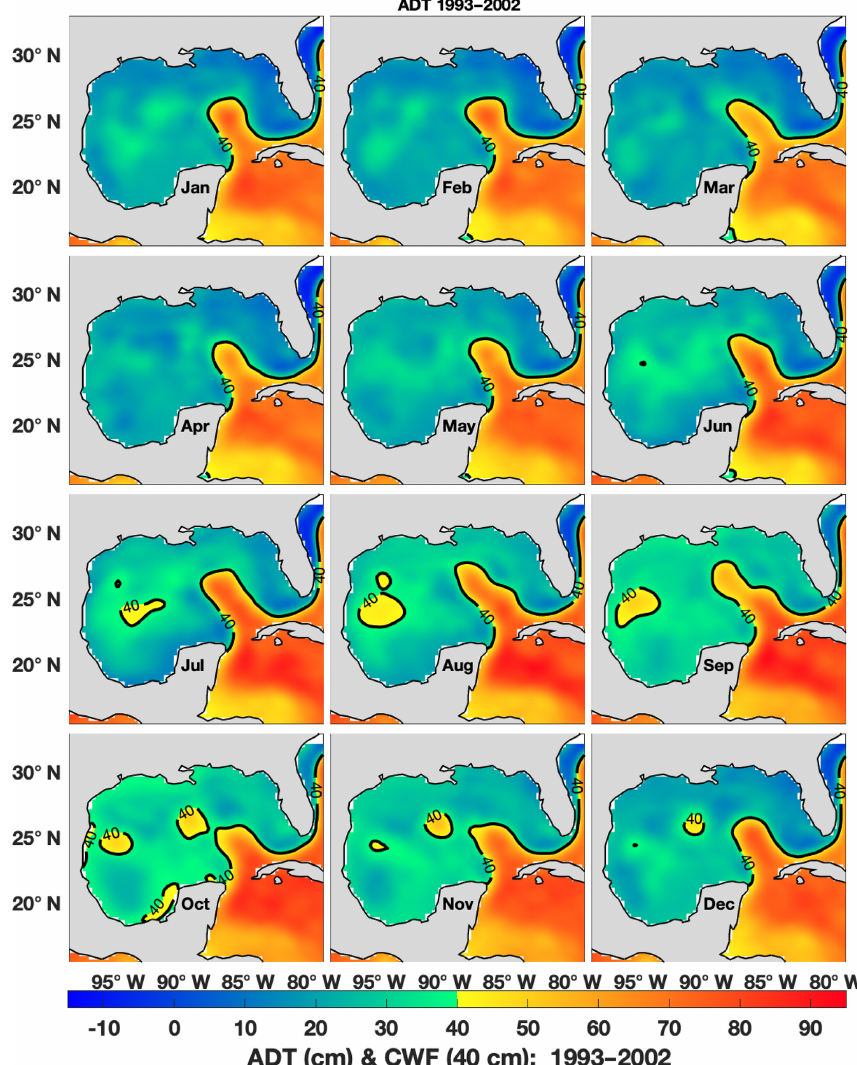
Figure 6. Monthly means of absolute dynamic topography (ADT) from 1993 to 2002 (color) and the respective CWF computed with the 40cm isoline (heavy black